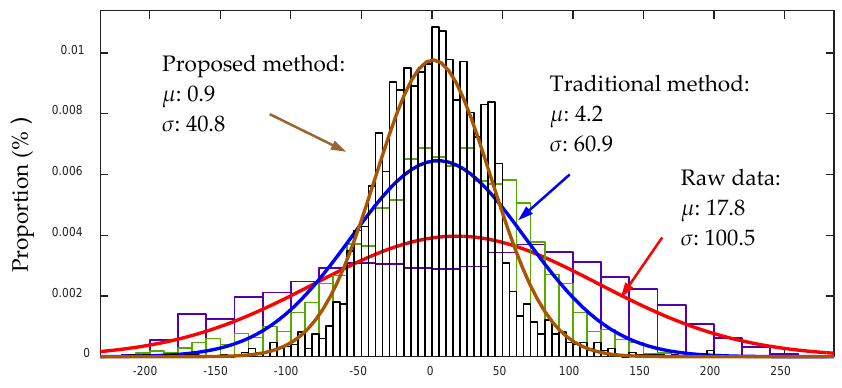
Figure 15. Consistency analysis of sediment variations. Lines A and B are two adjacent SSS lines, and Line AB is their mosaic image. The red rectangle denotes the peach-like shape of sediment distribution, and the blue one shows the shapes and positions of two submarine pipelines. The white lines between pings are caused by data losses. The location coordinates are same as Figure 14.